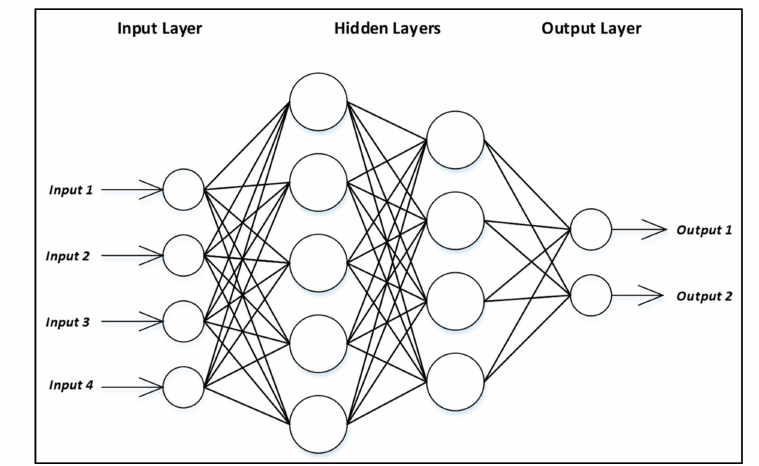
Figure 1. Simplified structure of MLP-NN.